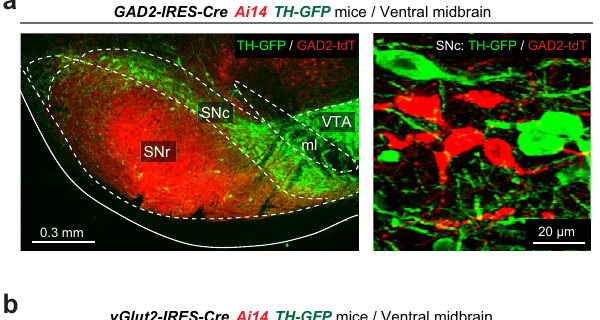
Fig. 2 Dopamine neurons are the primary postsynaptic target of the SC – SNc pathway. a An example coronal section with ventral midbrain (left) and the high-magni fi cation micrograph (right) showing the segregation of GAD2-tdT + neurons and TH-GFP + neurons in the SNc of GAD2-IRES-Cre/Ai14/TH-GFP triple transgenic mice. This experiment was repeated independently in fi ve mice with similar results. b An example coronal section with ventral midbrain (left) and the high- magni fi cation micrograph (right) showing the segregation of vGlut2-tdT + neurons and TH-GFP + neurons in the SNc of vGlut2-IRES-Cre/Ai14/ TH-GFP triple transgenic mice. This experiment was repeated independently in fi ve mice with similar results. c Schematic diagram showing injection of AAV-hSyn-ChR2-mCherry into the SC of GAD2- IRES-Cre/Ai14/TH-GFP or vGlut2-IRES-Cre/Ai14/TH-GFP mice (left) and whole-cell recording from TH-GFP + (green), GAD2-tdT + (red), or vGlut2-tdT + (red) neurons while illuminating ChR2-positive axon terminals from the SC (right). d , e Example traces ( d ) and quantitative analyses ( e ) of oEPSCs and oIPSCs from TH-GFP + and GAD2-tdT + neurons in the slices of GAD2-IRES-Cre/Ai14/TH-GFP mice. f , g Example traces ( f ) and quantitative analyses ( g ) of oEPSCs and oIPSCs from TH- GFP + and vGlut2-tdT + neurons in the slices of vGlut2-IRES-Cre/Ai14/ TH-GFP mice. Number of neurons is indicated in the graphs ( e, g ). Data in e , g are means ± SEM (error bars). Statistical analyses in e , g were performed by one-sided Student ’ s t -test (*** P < 0.001). Scale bars are indicated in the graphs.